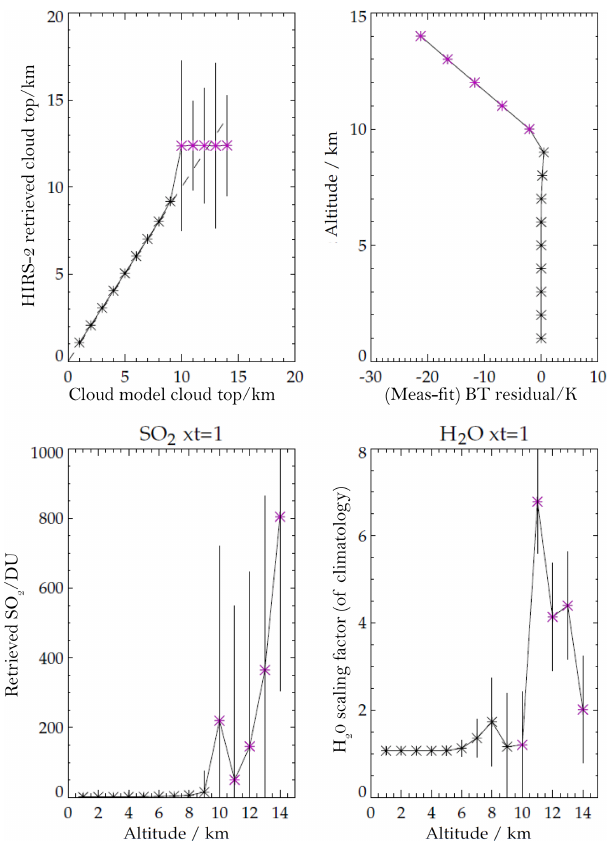
Figure 5. The top left plot shows retrieved cloud top height as a function of “true” cloud top height as simulated by the cloud model. Black symbols indicate that the retrieval converged, and purple in- dicates that it did not. The top right plot is of the fit residual (mea- surement minus fit) in the 11.1µm channel. The bottom left plot shows the retrieved SO 2 as a function of the cloud top height in the cloud model, and the bottom right the equivalent for the water vapour scaling